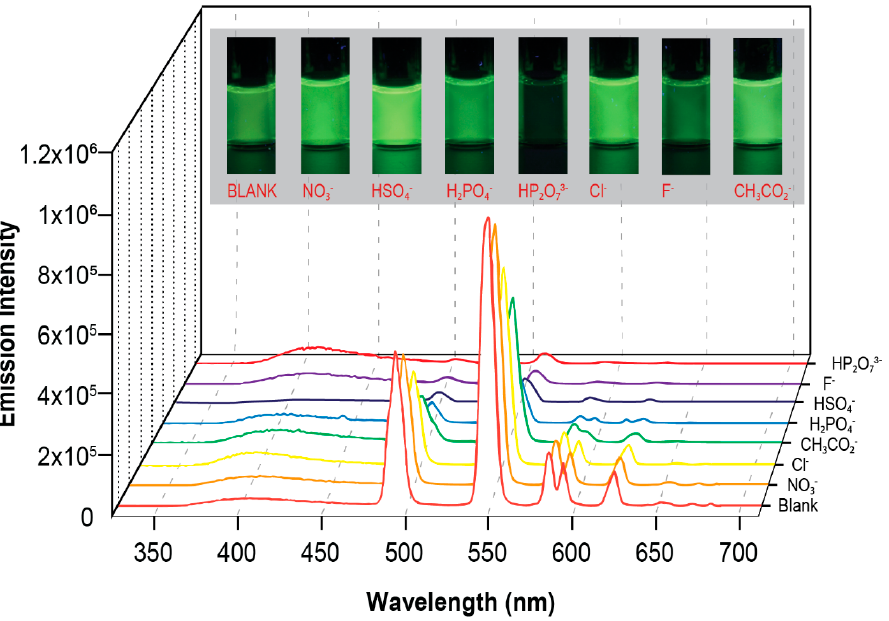
Figure 6. Steady state emission spectra of[ Tb. 1] (OTf) 3 (9.9 µM) in the presence of 1 equivalent of anions. Pictures show [Tb. 1] (OTf) 3 (50 µM) in the presence of 1 equivalent of each anion.